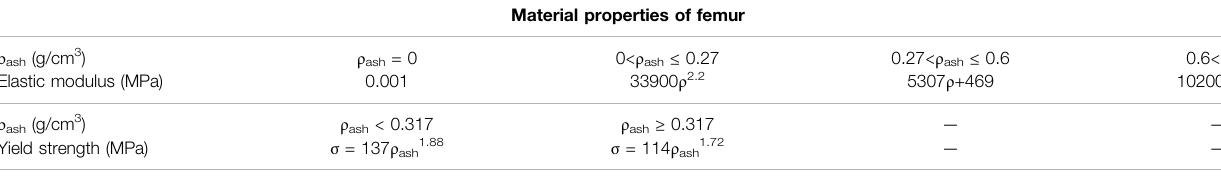
TABLE 1 | Material properties of femur (Gong et al., 2012).